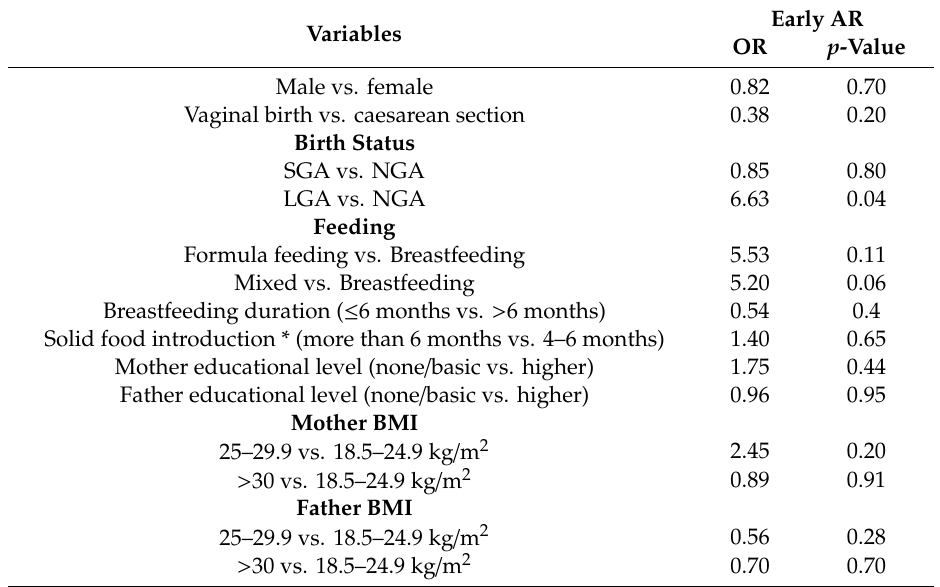
Table 5. Multivariate analysis for risk factors associated with early adiposity